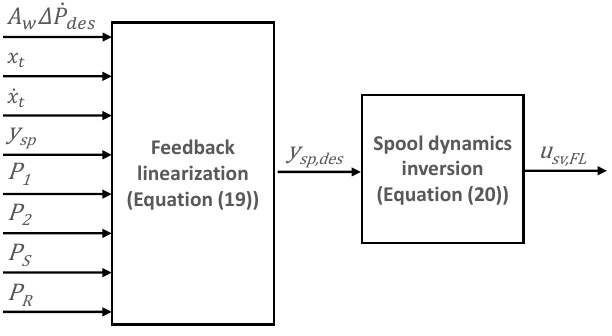
Figure 6. Feedback linearization scheme.